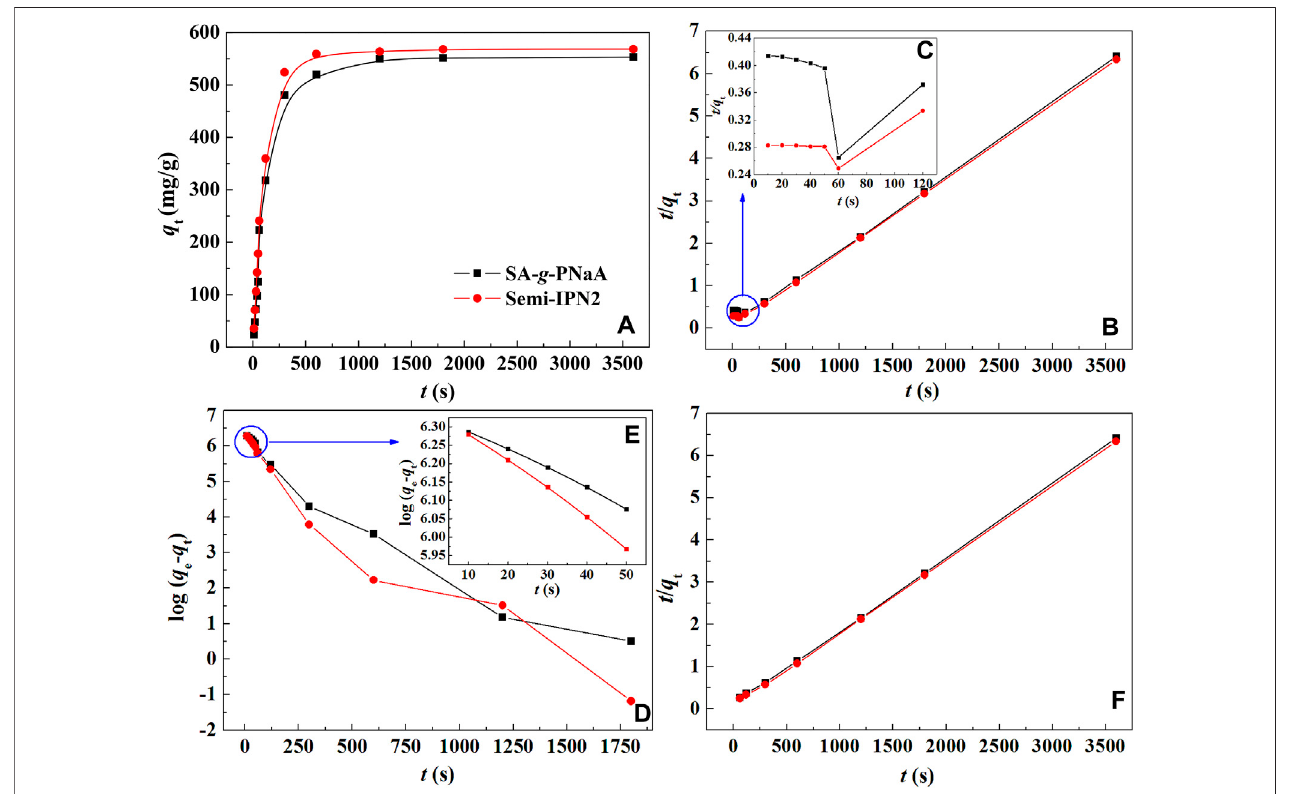
FIGURE 6 | (A) Adsorption kinetic curves of SA- g -PNaA and Semi-IPN2 hydrogels; (B) fi tting curves of t / q t versus t ; (C) the fi tting curves of t / q t versus t ( ≤ 120 s); (D) curves of log( q